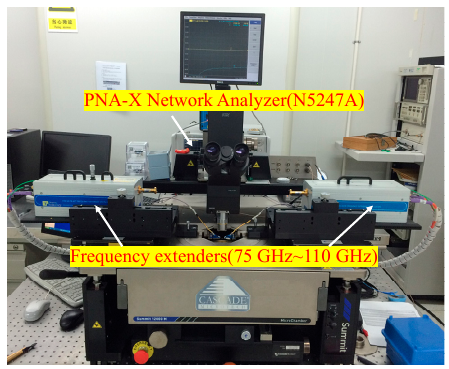
Figure 6. On-wafer measurement system for small signal characteristics.